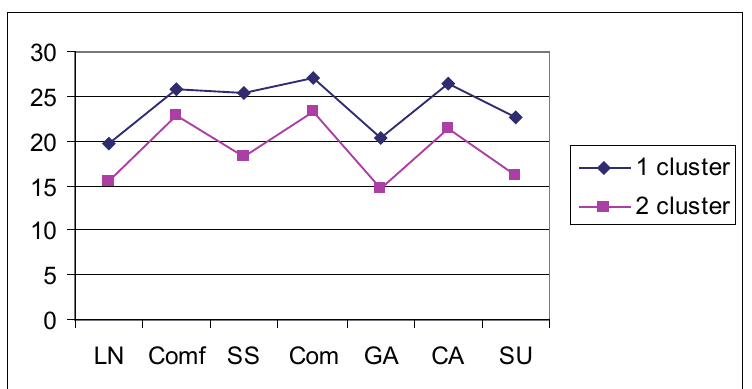
Figure 1. Motivational pro  le of students belonging to the  rst and second clusters. Source: